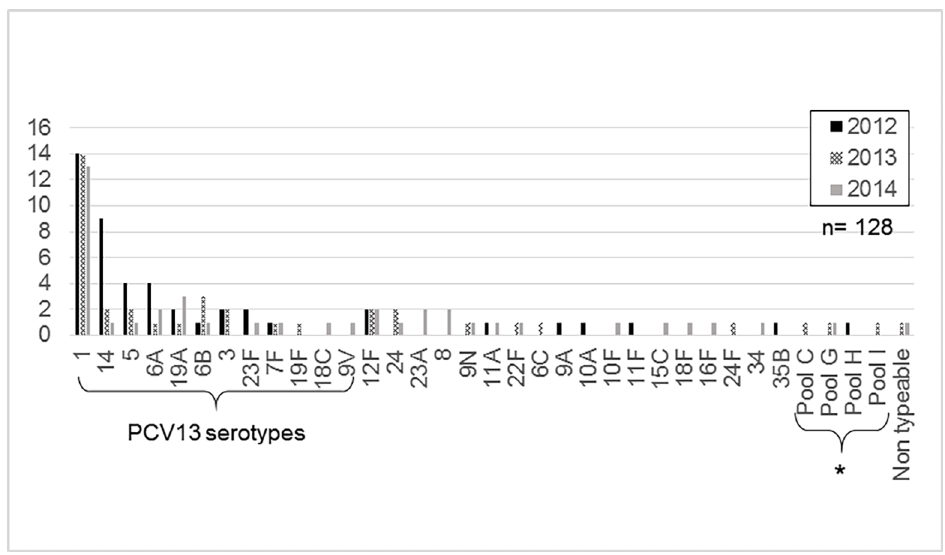
Fig 3. Pneumococcal pneumonia cases after PCV13 vaccine introduction: Distribution of S . pneumoniae serotypes. (cid:3) Partially typeable pools: C [24, 31 o´ 40], G [29,34,35,42 or 47], H [13 o´ 28], I [38, 25F or 25A].